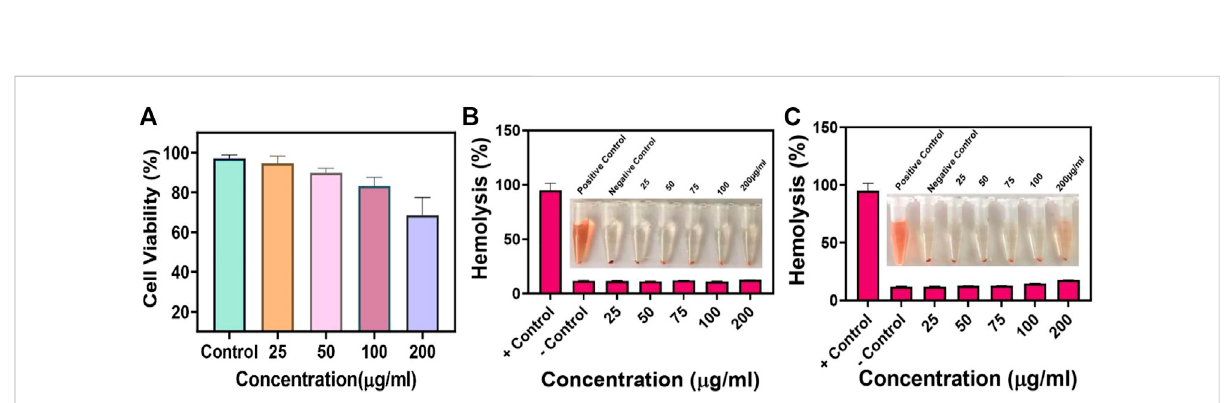
FIGURE 6 Biocompatibility of ZnO@8%Ag. (A) Cytotoxicity of ZnO@8%Ag under PTT/PDT in L929 cells, hemolysis rate of ZnO@8%Ag under PTT/PDT, inserted image of blood treated with varying concentrations of ZnO@8%Ag (25, 50, 75, 100, and 200 μ g/ml) aqueous solutions ddH 2 O (positive control) and PBS (negative control), (B) after 30 min, (C) after 1